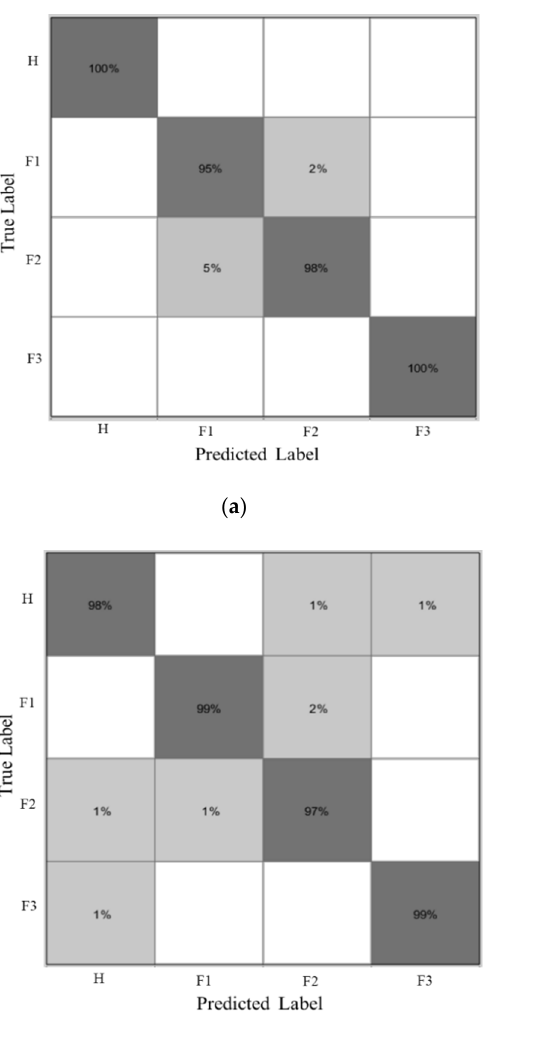
Figure 15. Three-dimensional visualization of features extracted from ( a ) the input signal of the ANR- GRS module and ( b ) the output signal of the ANR-GRS module.